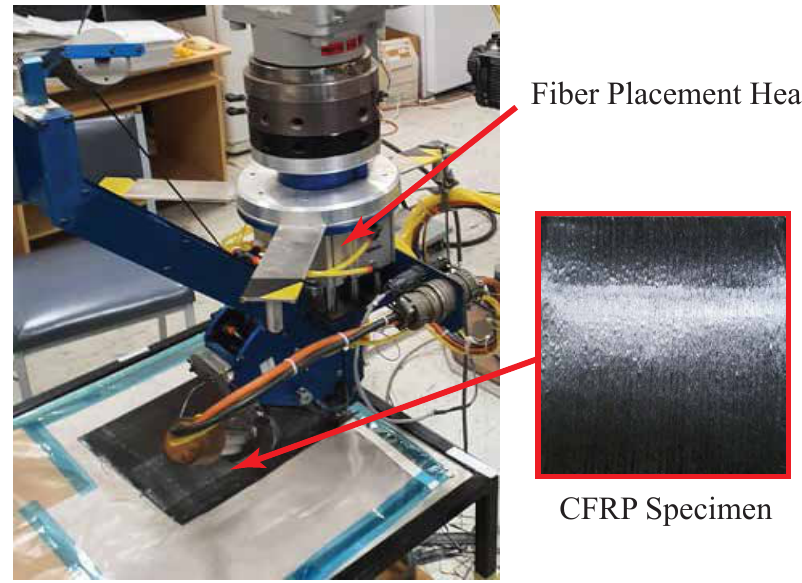
Figure 7. Composite manufacturing using the robotic fiber placement